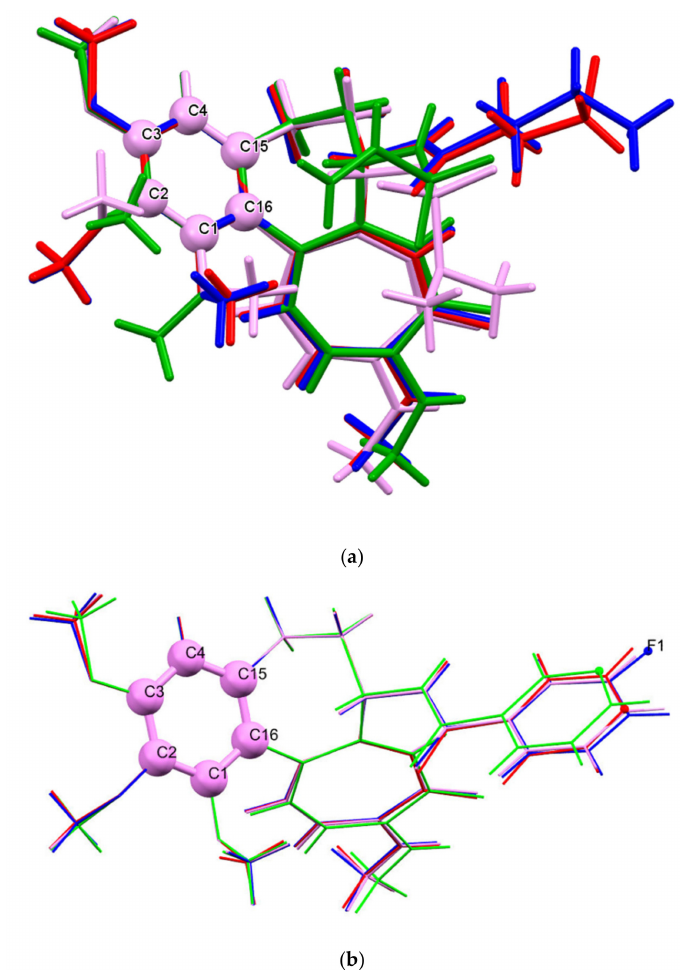
Figure 1. Comparison of the X-ray structure of ( a ) derivatives with a chain substituent at position C7: 6 (blue), 11 (red), 18 (pink) and 19 (green) and ( b ) derivatives with a substituent containing an aromatic ringatpositionC7: 12 (pink), 14 (blue), 15 (green)and 16 (red)showingtheconformationofthecolchicine skeleton. The molecules are overlapped one over another so that the ring C1-C2-C3-C4-C15-C16 is at the same